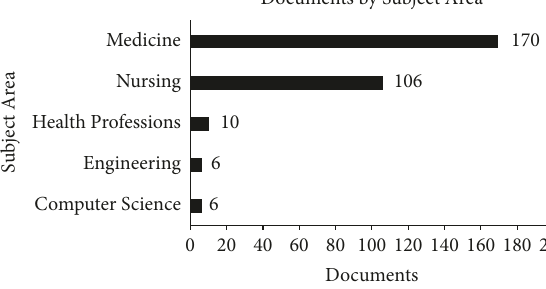
Figure 6: Documents by subject